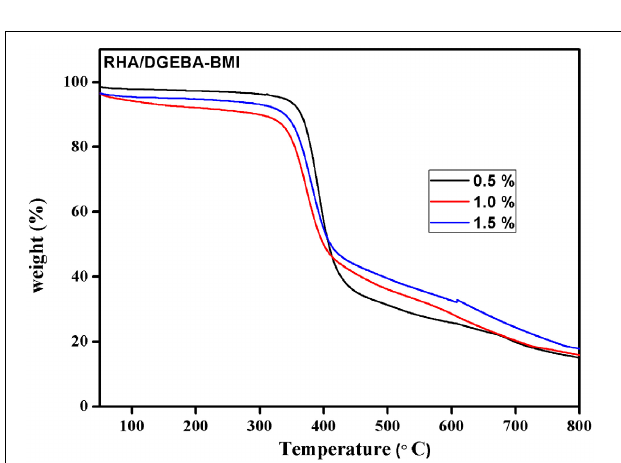
FIGURE 8 | Thermogram of RHA/DGEBA-BMI nanocomposites.